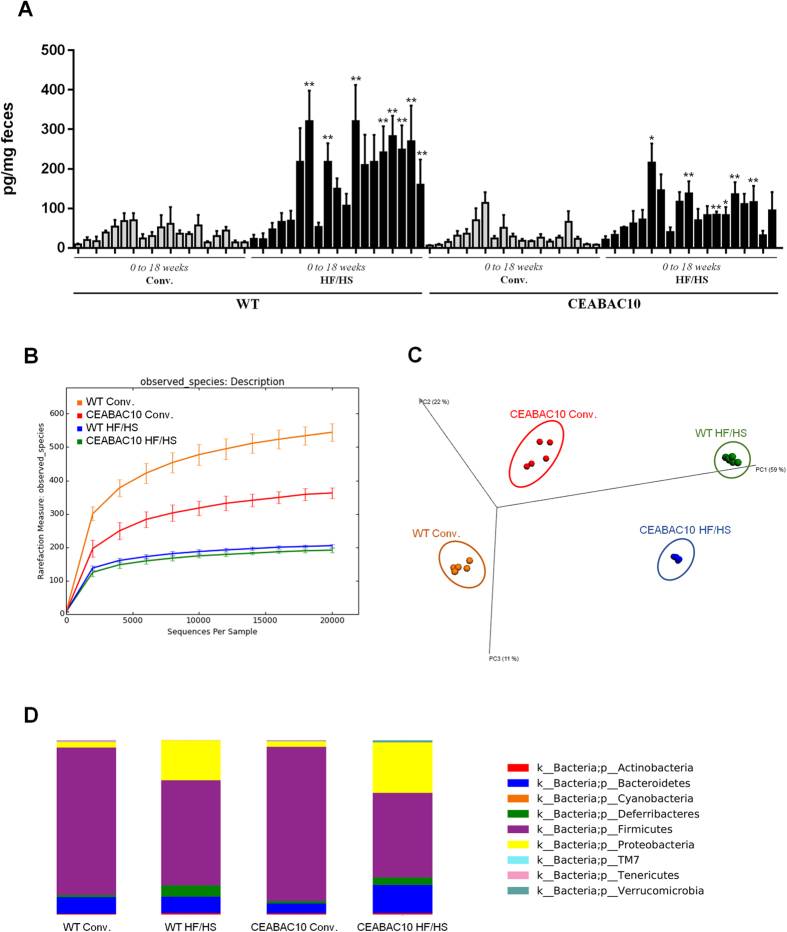
Western diet causes an inflammatory environment in the digestive tract associated with microbiome perturbations.WT and CEABAC10 mice were treated with a conventional or an HF/HS diet for 18 weeks (N = 5 per Conv. groups and N = 6 per HF/HS groups) (A) The fecal Lcn-2 levels were measured each week during the treatment (*P < 0.05; **P < 0.01 in WT and CEABAC10 mice under conventional and HF/HS diet; The statistically different Lcn-2 values was determined using a Mann-Whitney test between the diets, for each genotypes. (B) Rarefaction curves of the bacterial species richness, mean values are indicated for each group of mice. (C) PCoA plots based on of the unweighted UniFrac distance matrices showing clustering of mice regarding their global microbiota composition. (D) Relative abundance of phyla in fecal samples between groups of mice.